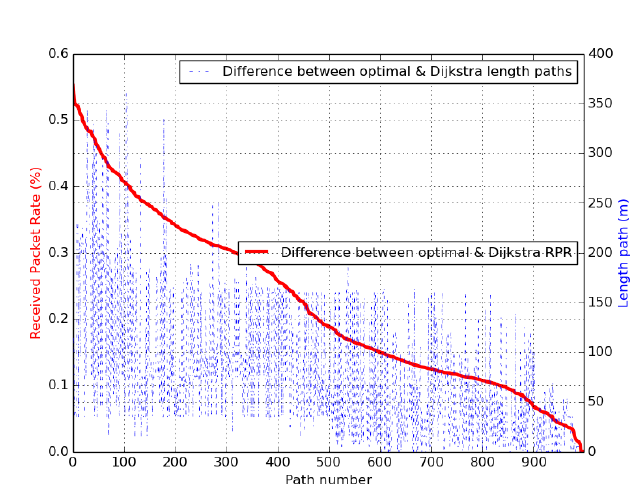
Figure 15. Difference between optimal and Dijkstra RPR, nbr paths = 1000 Finall y, the figur 18 summarizes and illustr